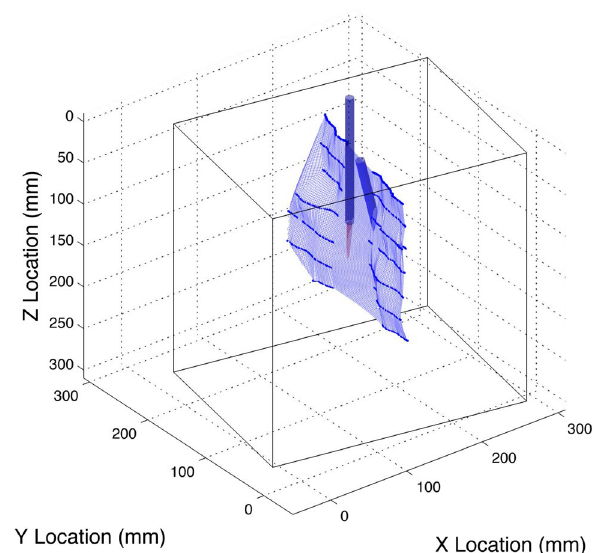
Fig. 12 Main hydraulic fracture visible from the slabbed sample data. Darker blue circles represent the individual data points digitized from the slab images. Lighter blue surface is an interpolation between the slab